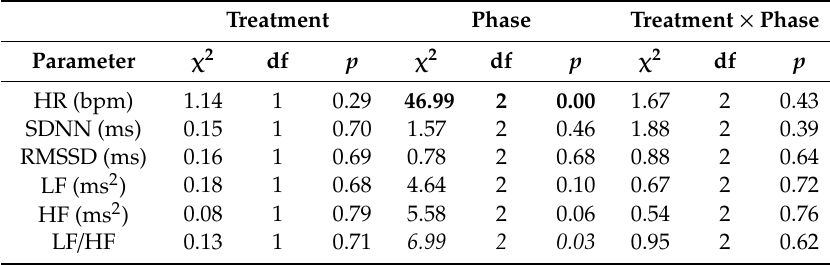
Table 2. Results of statistical analysis of heart rate (HR) and heart rate variability (HRV) parameters of heifers ( n = 28). Results that remained significant after false discover rate control (FDRC; p < 0.05) appear in bold, trends ( p < 0.1) in italics; statistics: LMMs. SDNN: standard deviation of the inter ‐ beat intervals, RMSSD: square root of the mean squared differences of successive inter ‐ beat intervals, LF: normalised power of low frequency, HF: normalised power of high frequency.